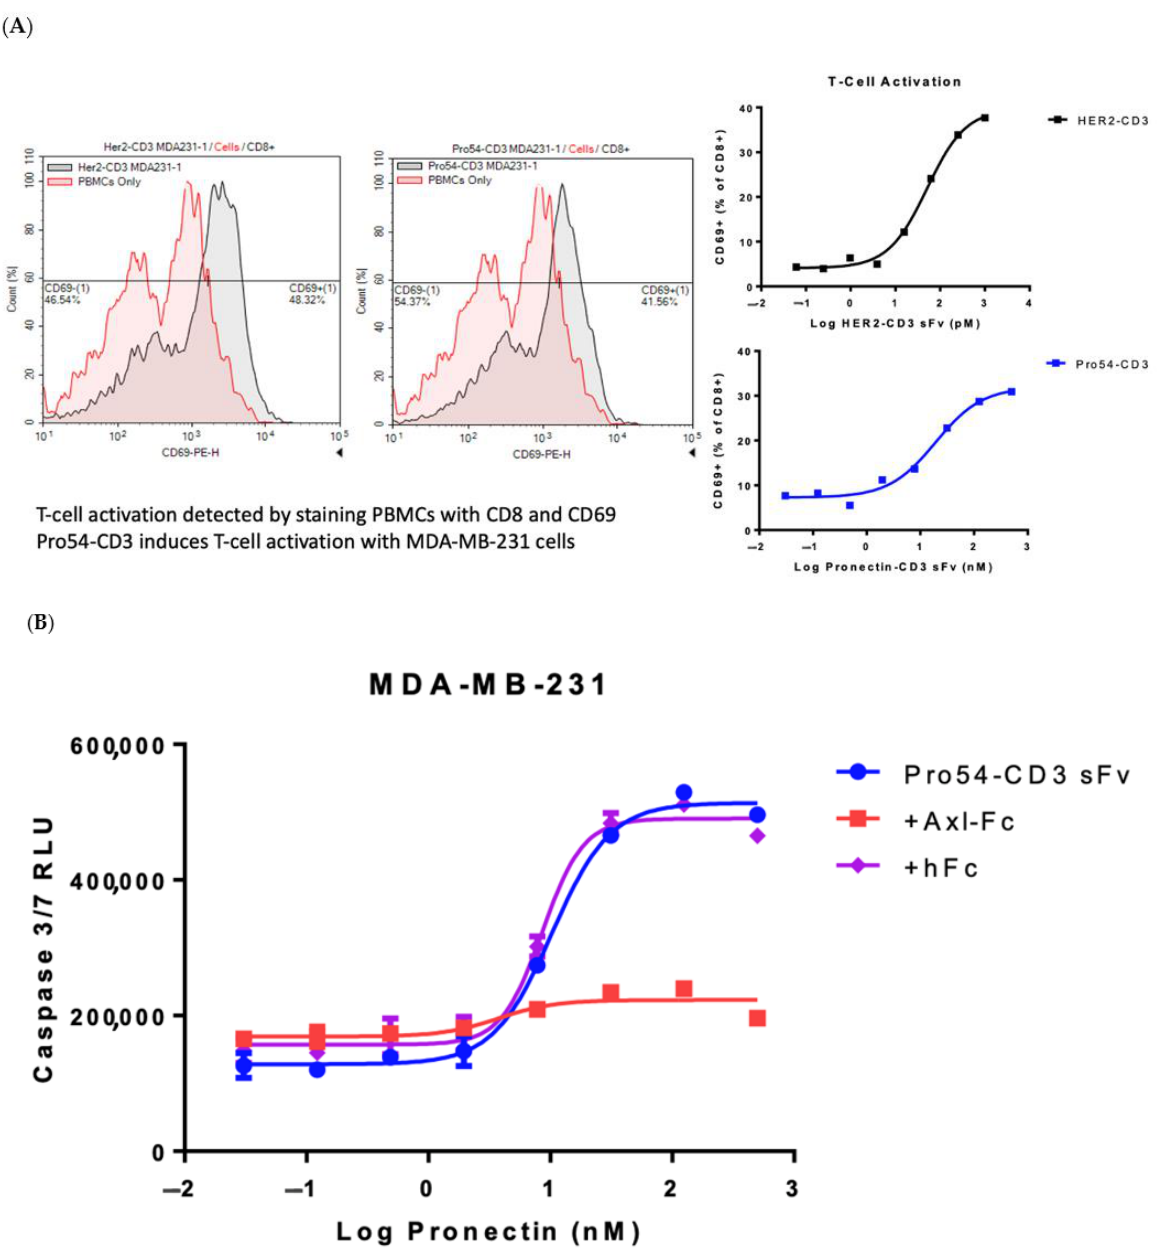
Figure 11. ( A ) Shows the increase in CD69 levels on the CD8+ PBMC cells with the addition of